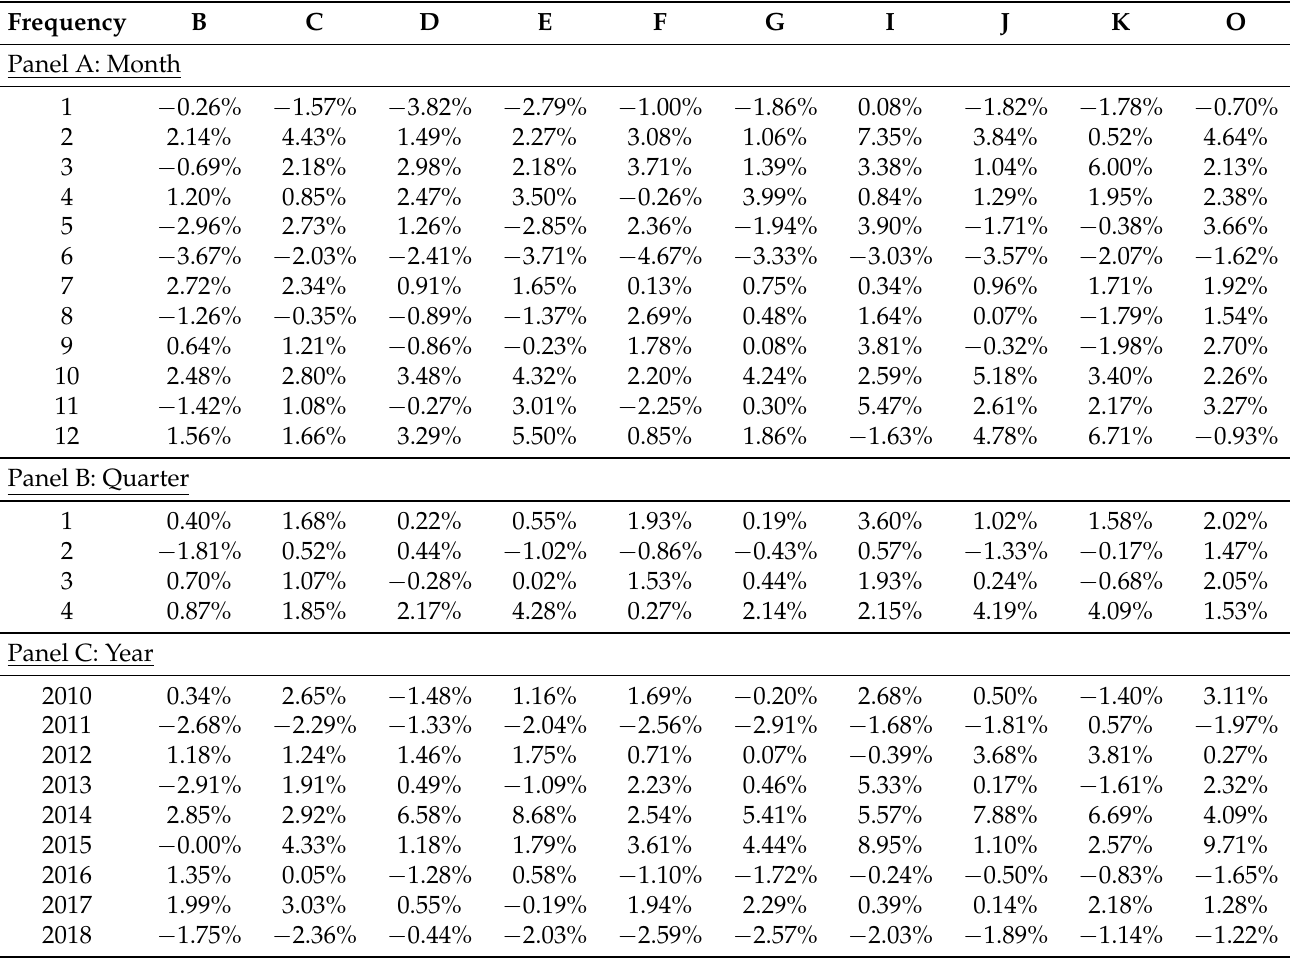
Table 10. Seasonality analysis of sector